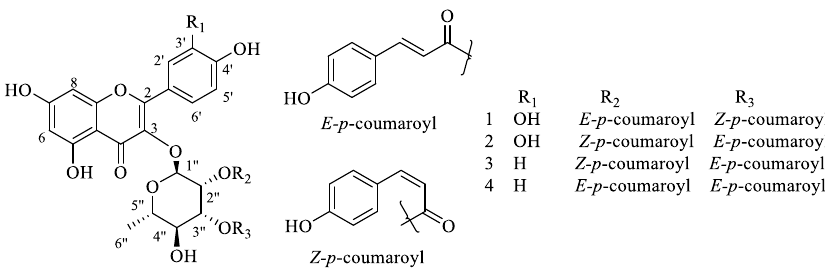
Figure 1. Chemical structures of flavonoid glycosides 1 – 4 from P. × acerifolia